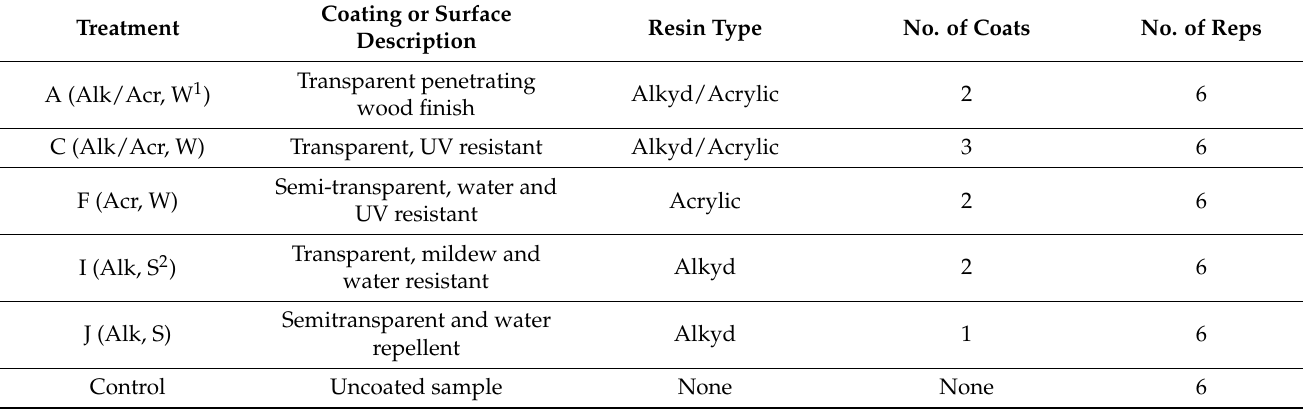
Table 1. Coating treatment